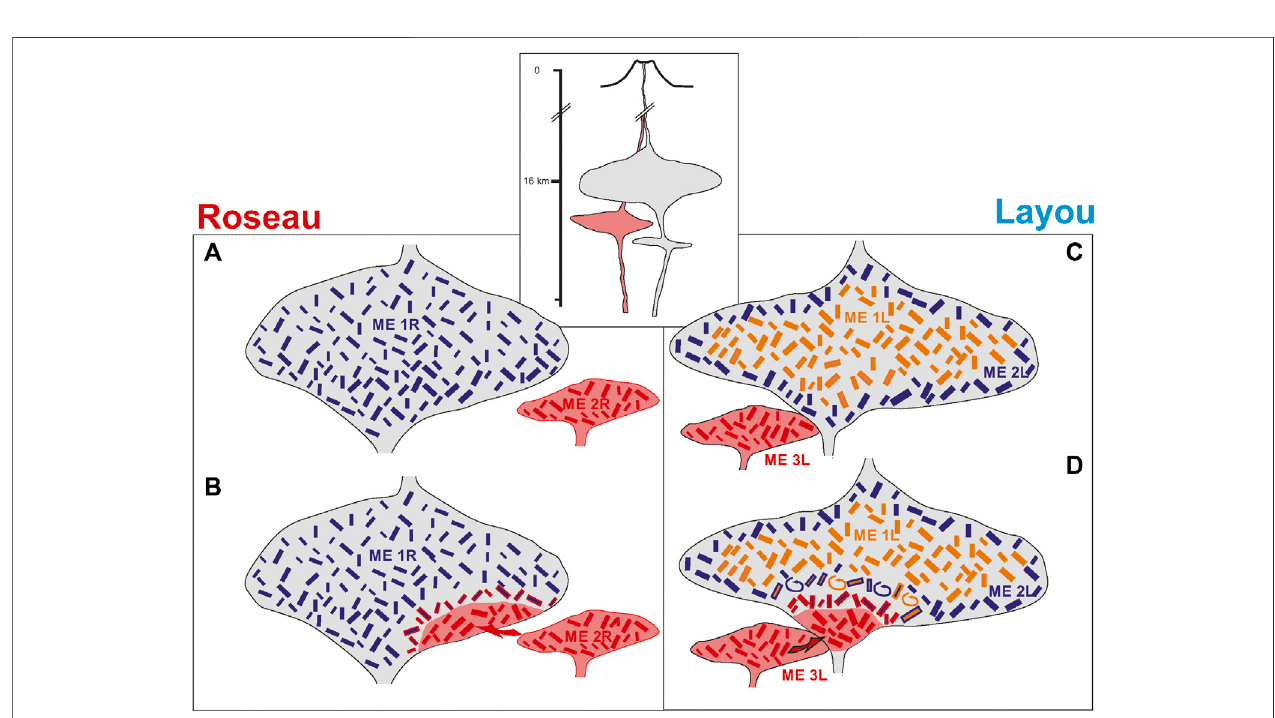
FIGURE8| Adynamicmagmamodelwithinthecrust.Inset:Localizationwithinthecrustofthemushzonestudiedhere.Thecolorofthecrystalislinkedtomagma temperature, from “ cold ” environment in blue to “ hot ” one in red, with intermediate temperature in orange; relative temperature estimates are on the basis of opx composition. Initial stage for (A) Roseau and (C) Layou. The dynamic model proposed on the basis of opx for (B) Roseau and (D) Layou.